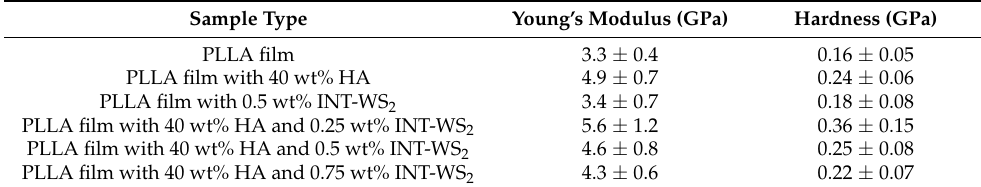
Table 3. Parameters determined from the nanoindentation of PLLA film and HA/INT-WS 2 /PLLA